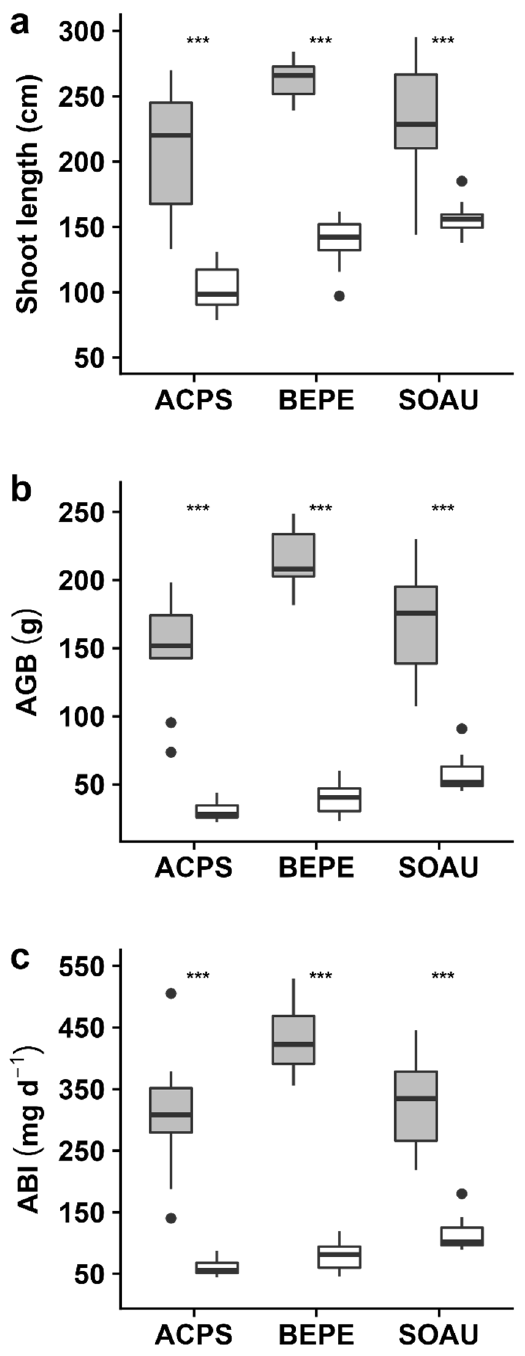
Figure 2. Boxplot of growth-related traits of Acer pseudoplatanus (ACPS), Betula pendula (BEPE), and Sorbus aucuparia (SOAU) for the control (grey) and stress (white) treatment. Presented are ( a ) shoot length, ( b ) aboveground biomass (AGB), and (c) aboveground biomass increment (ABI). Asterisks indicate the level of significance (***, p < 0.001; ns, for non-significant).